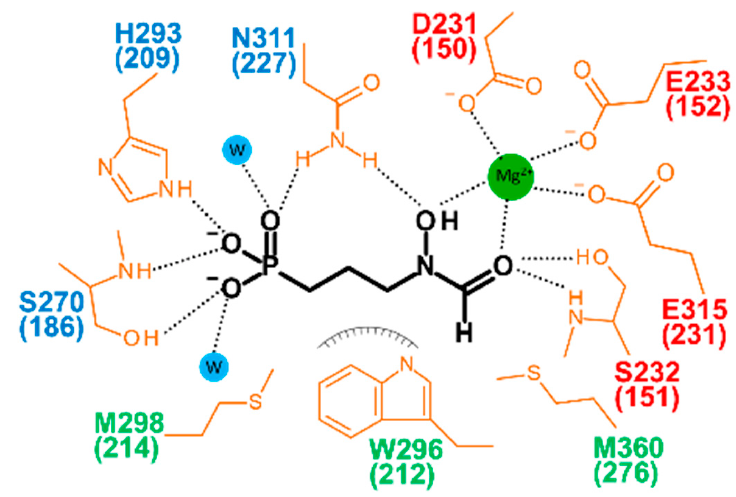
Figure 7. The binding mode of fosmidomycin in the active site of Pf DXR. Residues involved in the inhibitor binding are colored as in Figure 6A. The number in the parentheses indicates the residue number for the equivalent residue of Ec DXR.